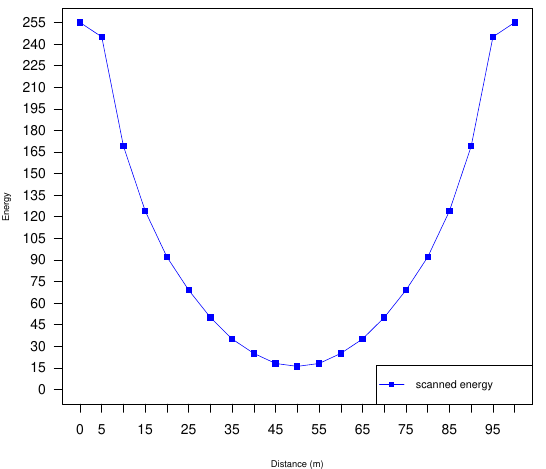
Figure 6. Node energy scan with increasing distance: coordinators set at 0 m and 100